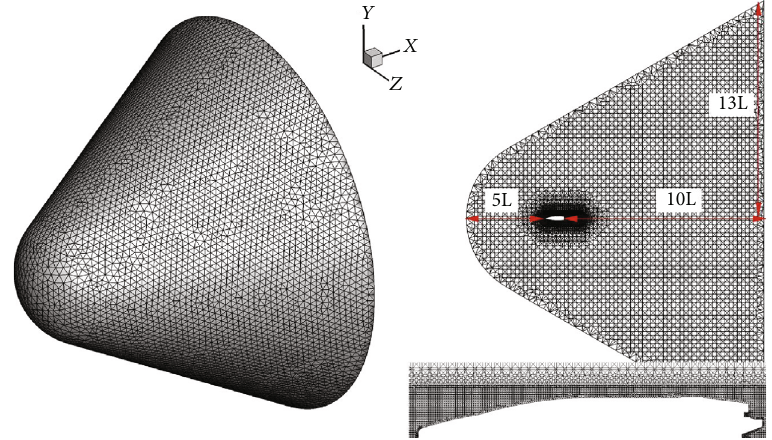
Figure 2: Computational domain and grid system.